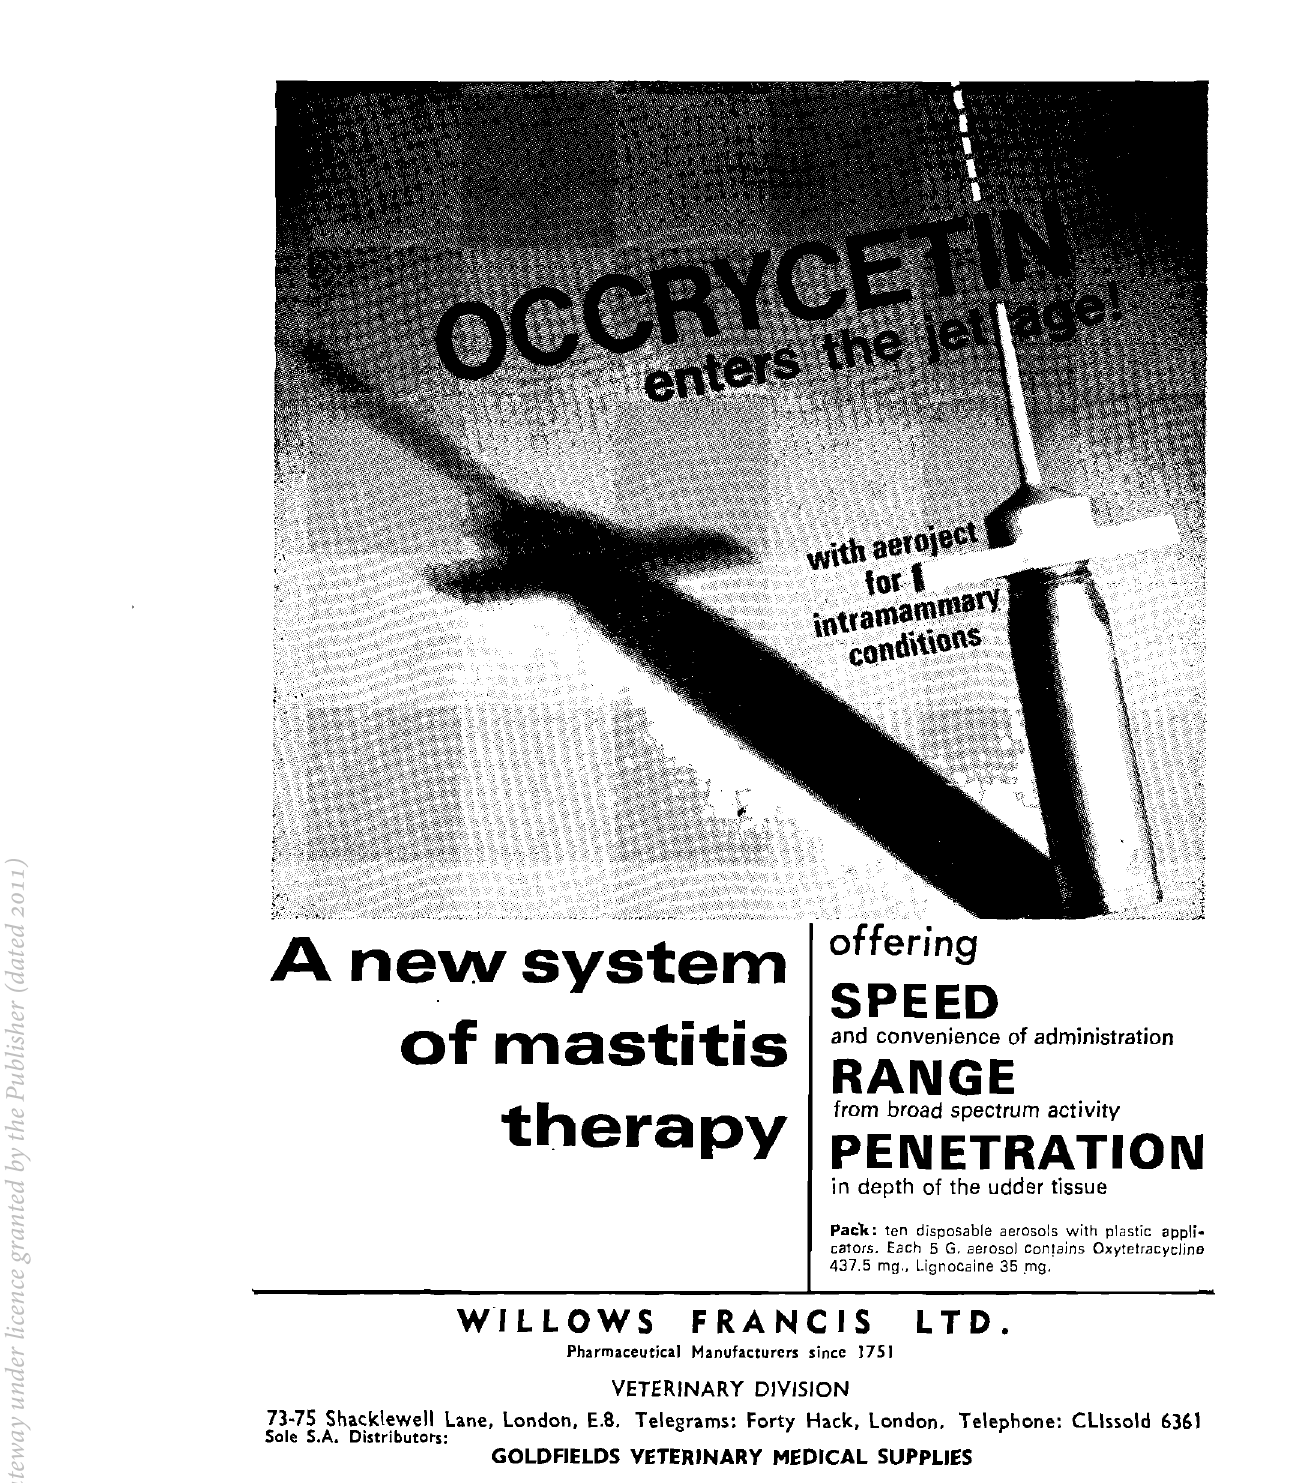
in depth of the udder tissue pack: ten disposable aerosols with plastic appli cators. Each 5 G. aerosol con!ain.